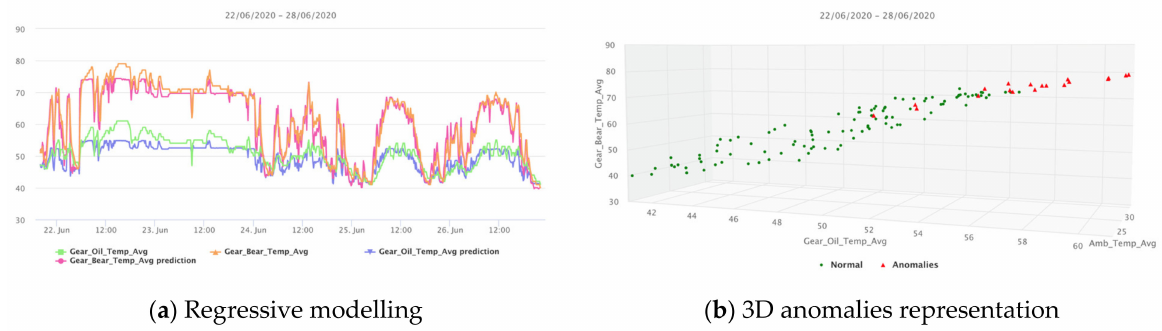
Figure 14. AI results representation.